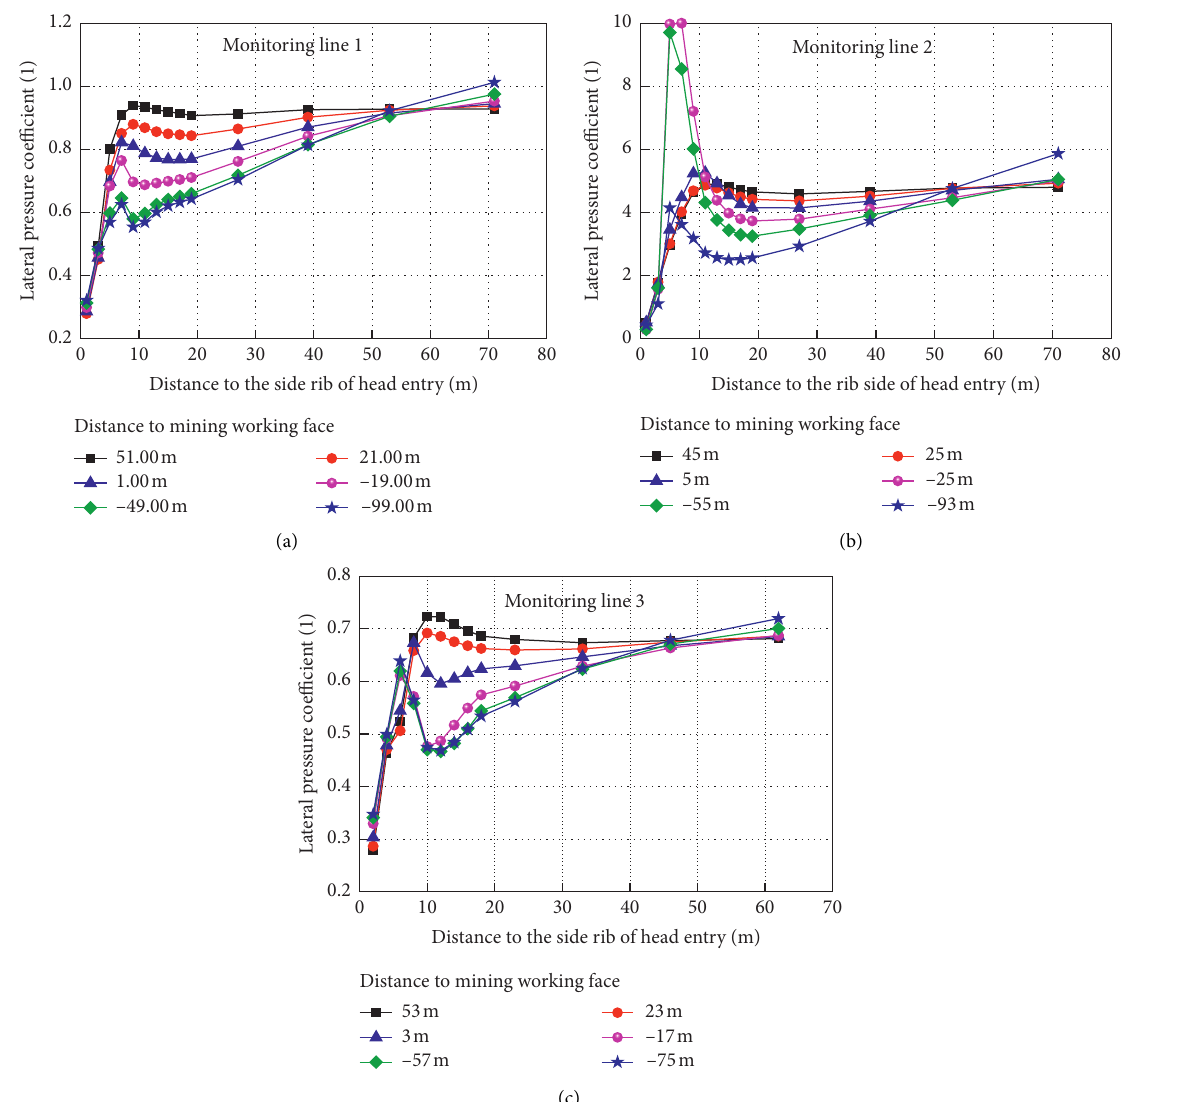
Figure 10: Lateral pressure coefficient of abnormal stress in lateral of the mining working face. (a) Monitoring line 1, (b) monitoring line 2, and (c) monitoring line